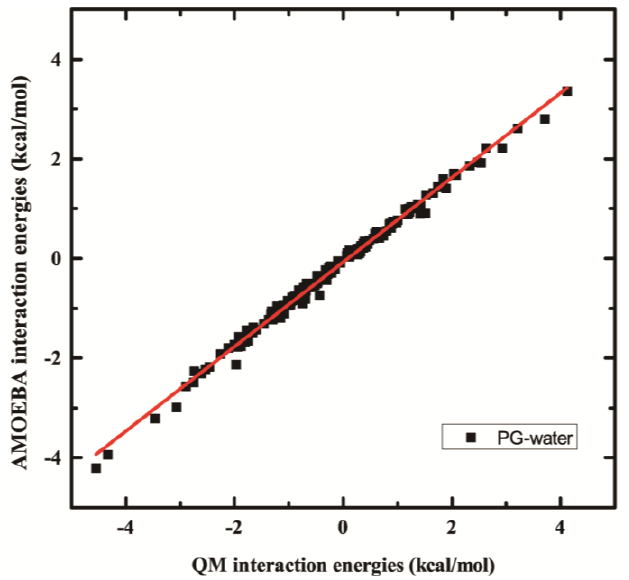
Figure 4. Comparison of association energies predict by AMOEBA and QM (MP2/6-311++G**). The binding energies were calculated for the PG headgroup with water.